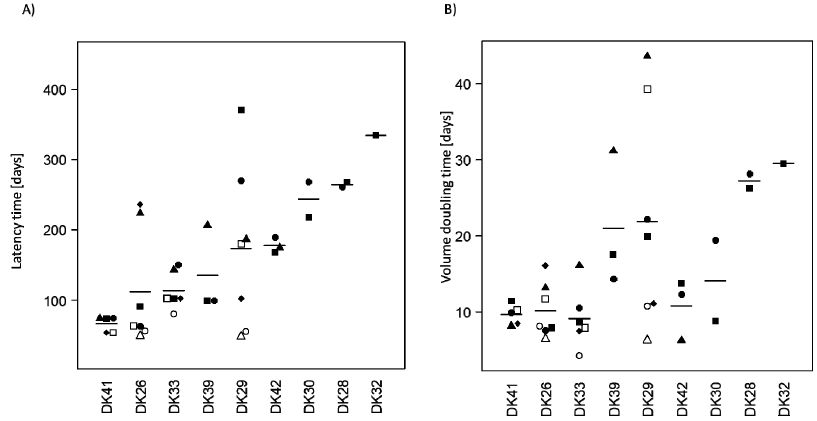
Figure 2. Growth parameters in the first-generation glioblastoma PDXs. ( A ) The latency time is defined as the time after transplantation until observation of a 40 mm 3 tumour. ( B ) The volume doubling time (VDT) was estimated for each first-generation PDX; the mean value is represented for each model. The latency time and the VDT correlate ( r = 0.67, p < 0.0001). Models are sorted by increasing mean latency times. Each symbol represents a PDX in the respective model. DK35: data not available as the tumour did not reach the required size for